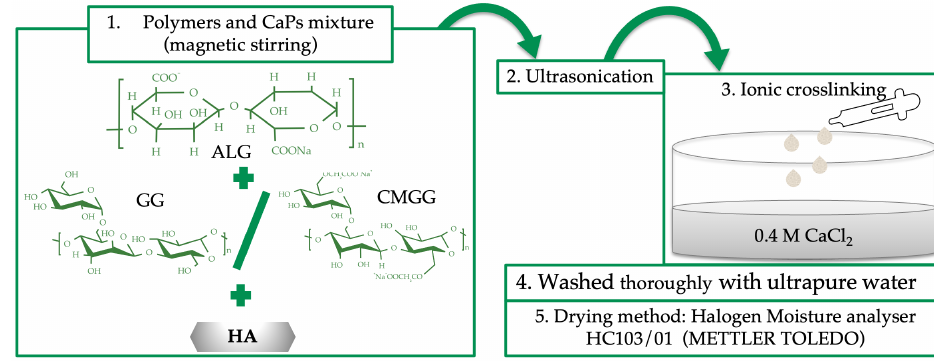
Figure 1. Composite beads preparation flowchart. Table 1. CBs codification and composition.